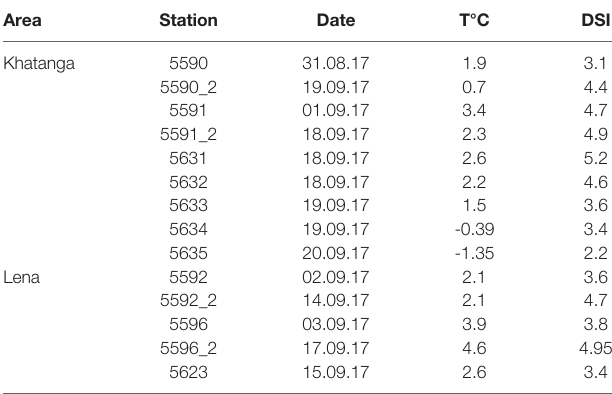
TABLE 3 | Development stage index of Calanus glacialis population (DSI) in the Khatanga and Lena affected areas. Area Station